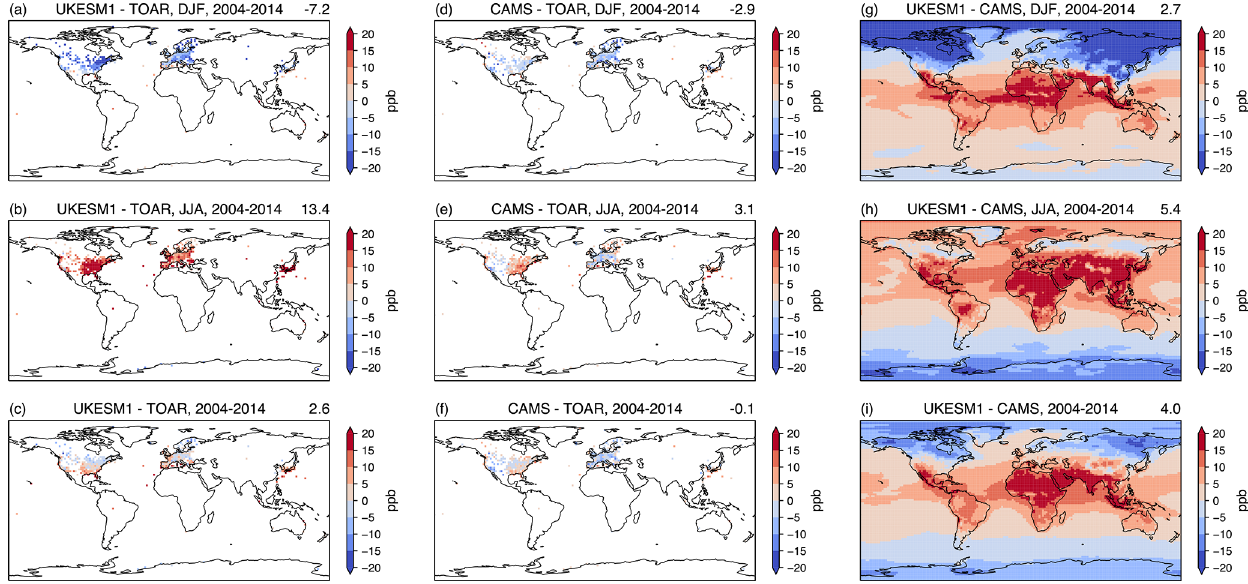
Figure 2. Comparison of seasonal mean (December–January–February (DJF) and June–July–August (JJA)) and annual mean surface O 3 mixing ratios between (a–c) UKESM1 and TOAR, (d–f) CAMS and TOAR, and (g–i) UKEMS1 and TOAR, all averaged over 2004–2014. Global area-weighted average surface mean mixing ratios (ppb) are shown in the top right of each panel.